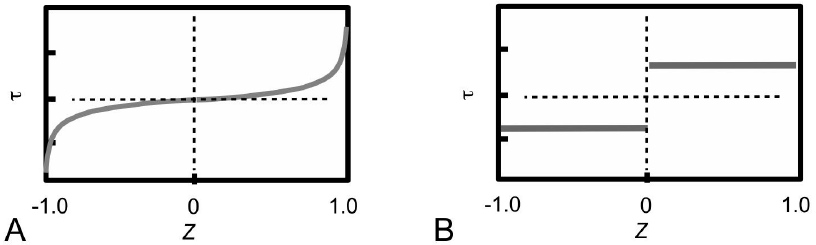
Figure 5. Fibre-matrix interfacial shear stress, τ , distributions [99,101]. ( A ) Shear-lag model; ( B ) Shear- sliding model. Here Z represents the normalized coordinate, i.e., Z = z / L CF , where z is the z coordinate of the cylindrical polar coordinate system and L CF represents the half-length of the fibril. Z is used to describe the distance along the fibre axis from the fibre centre, Z = 0, to the respective fibre ends, Z = 1 or − 1.